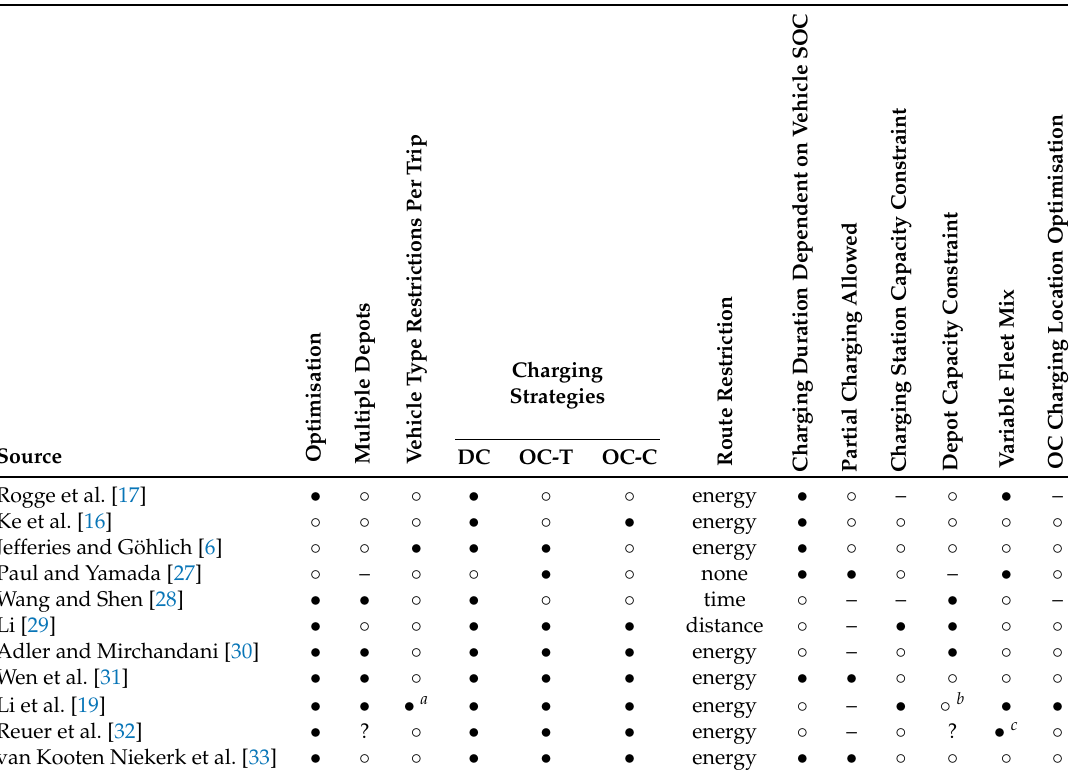
Table 1. Comparison of electric bus scheduling methods. Legend: • yes; ◦ no; – not applicable; ?